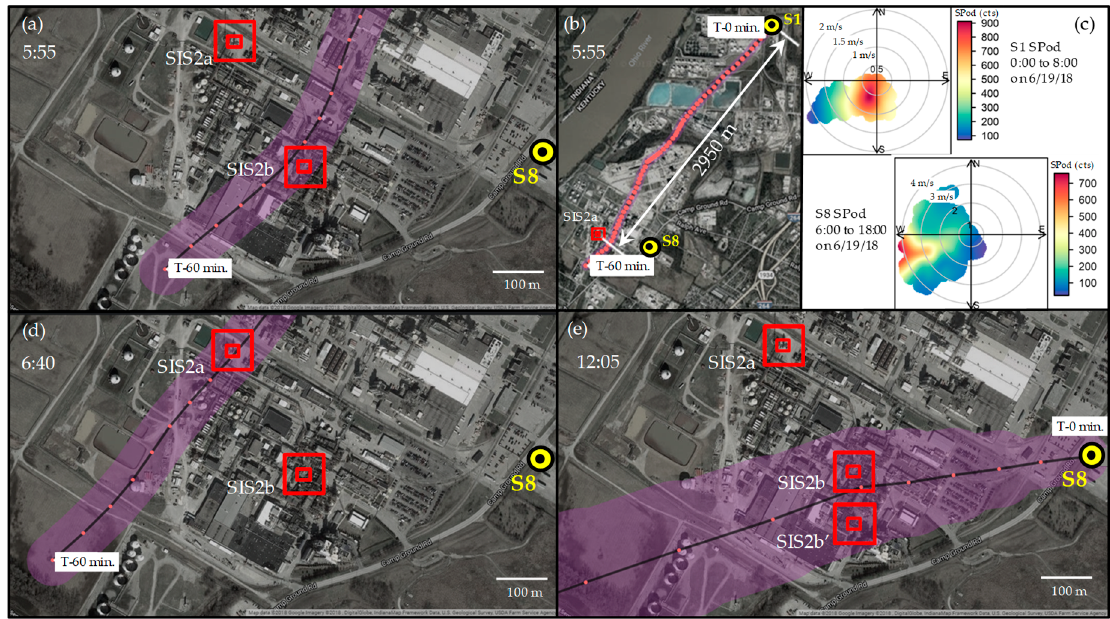
Figure 7. BTMs of SIS2 on 6/19/2018: ( a ) expanded view of 5:55 model from S1 ( b ) full view of 5:55 model from S1, ( c ) SPod SDI plot from S1 (top) and S8 (bottom), ( d ) expanded view of 6:40 model from S1, and ( e ) expanded view of 12:05 model from S8 with QUIC model optimized location SIS2b’ indicated. The concentric red boxes represent the near-optimal trial source location from TCTA, with the inner box approximating the defined source areas for the TCTA calculation.